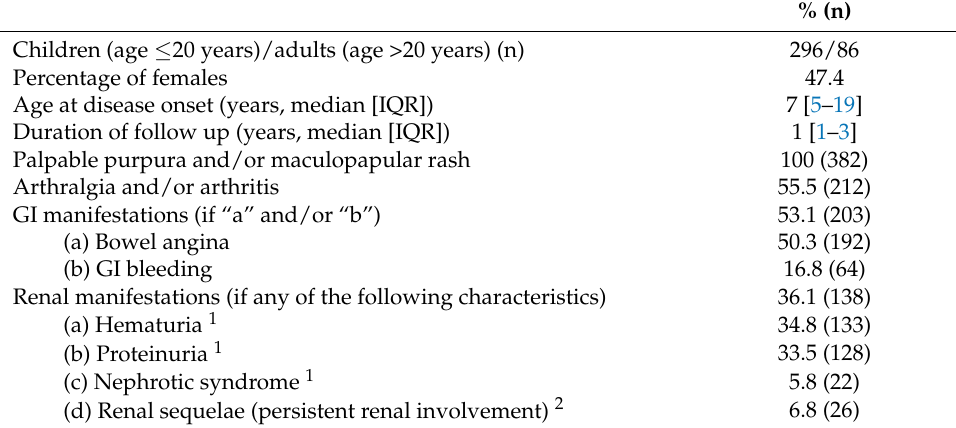
Table 1. Main clinical characteristic of the 382 IgAV patients recruited in our